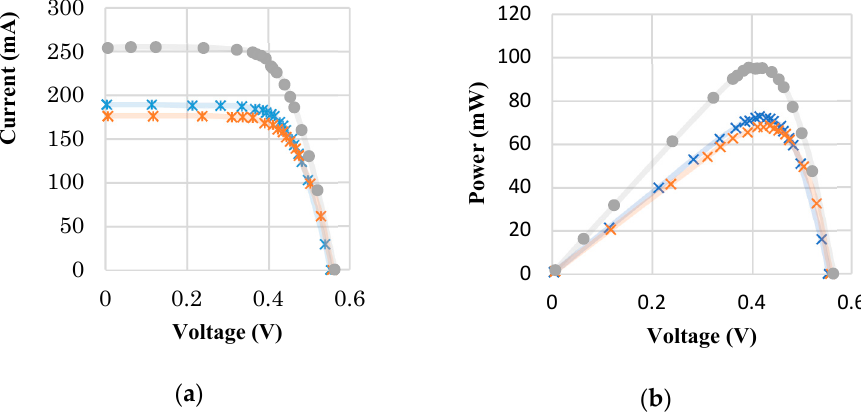
Figure 8. Experiments performed on 21 May 2018: without filters ( — ), with filter OG 515 ( — ), and filter OG 550 ( — ) for m-Si cell. ( a ) Voltage-current curves and ( b ) voltage-power curves. Both curves were acquired for G = 910 W/m 2.